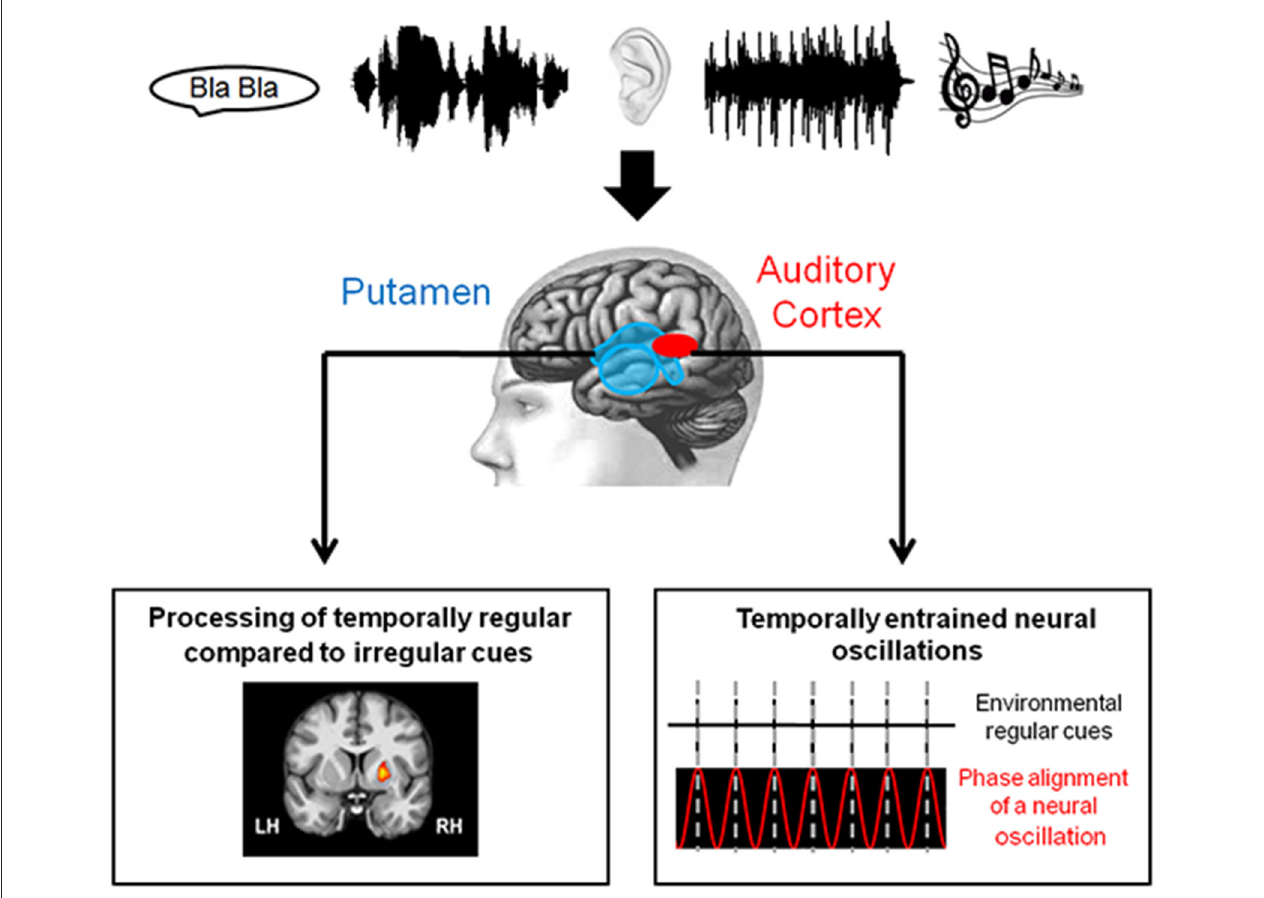
FIGURE 1 | Schematic illustration of the neural correlates of sensory entrainment. Temporally structured auditory signals reach the sensory system (e.g., in the forms of speech and music). Neural correlates of sensory entrainment include synchronization of neural oscillations in the sensory cortices (Gross et al.,